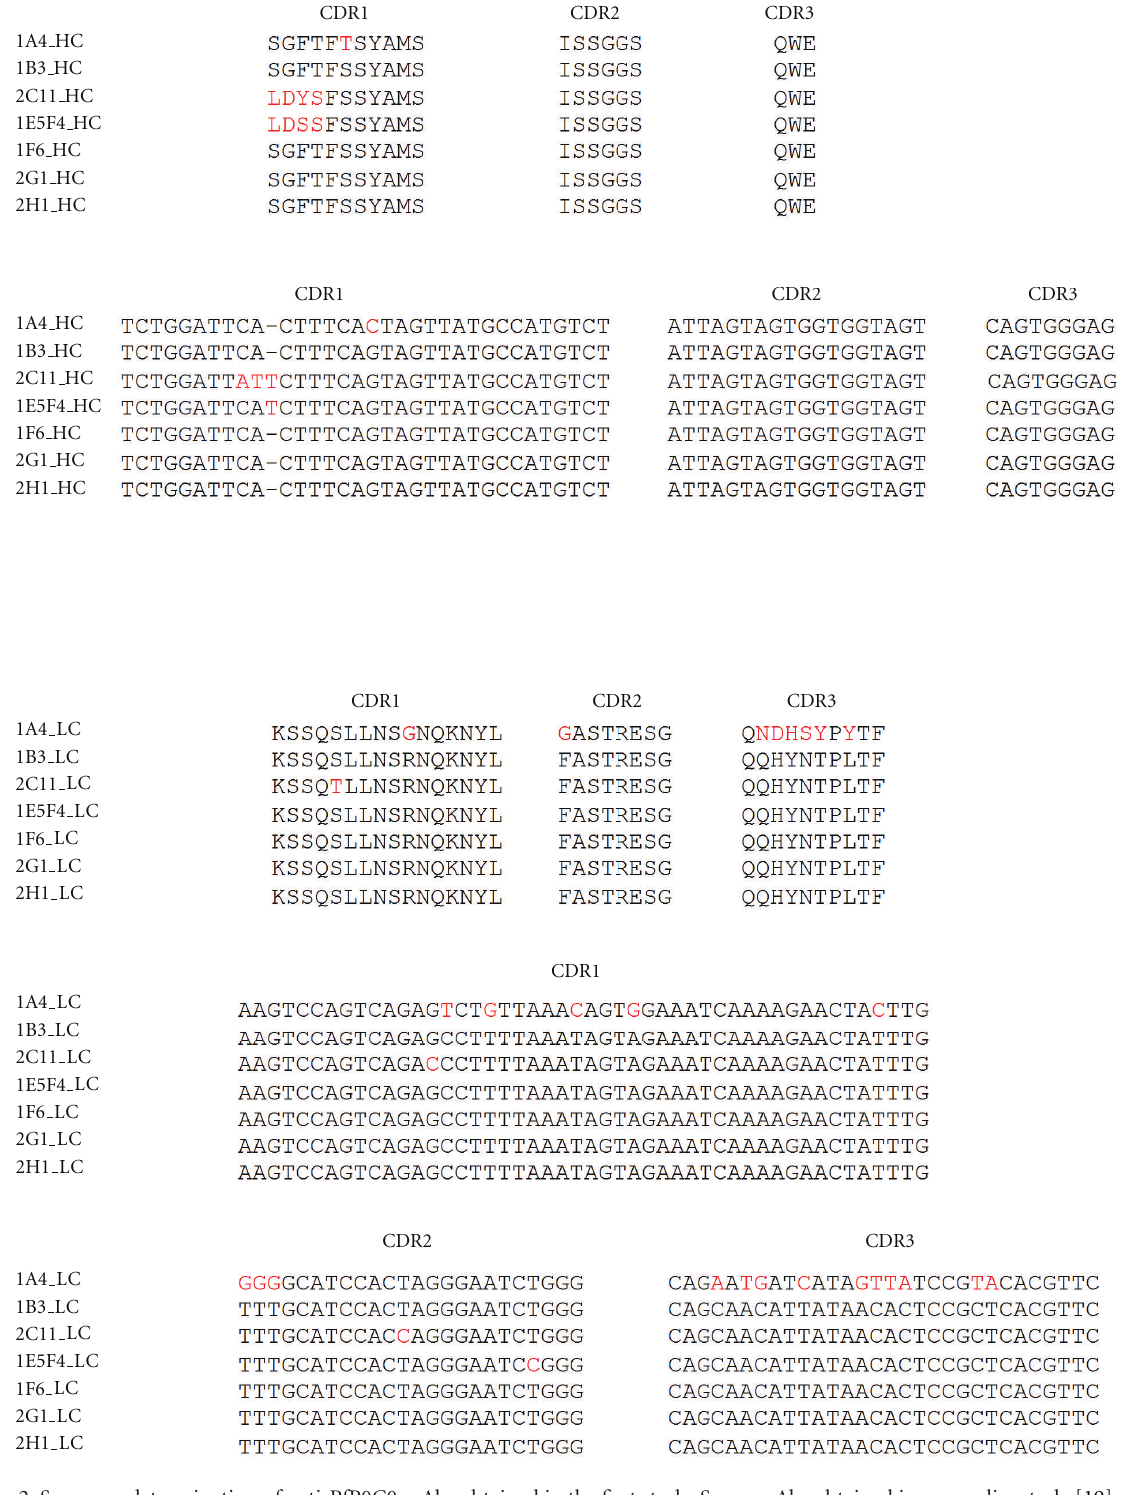
Figure 2: Sequence determination of anti-PfP0C0 mAbs obtained in the first study. Seven mAbs obtained in our earlier study [19], namely, 1A4, 1B3, 2C11, 1E5F4, 1F6, 2G1 and 2H1 were sequenced to determine their relatedness. Except for some minor variations (in red), all seven mAbs were nearly identical, suggesting that they had arisen from a single B cell